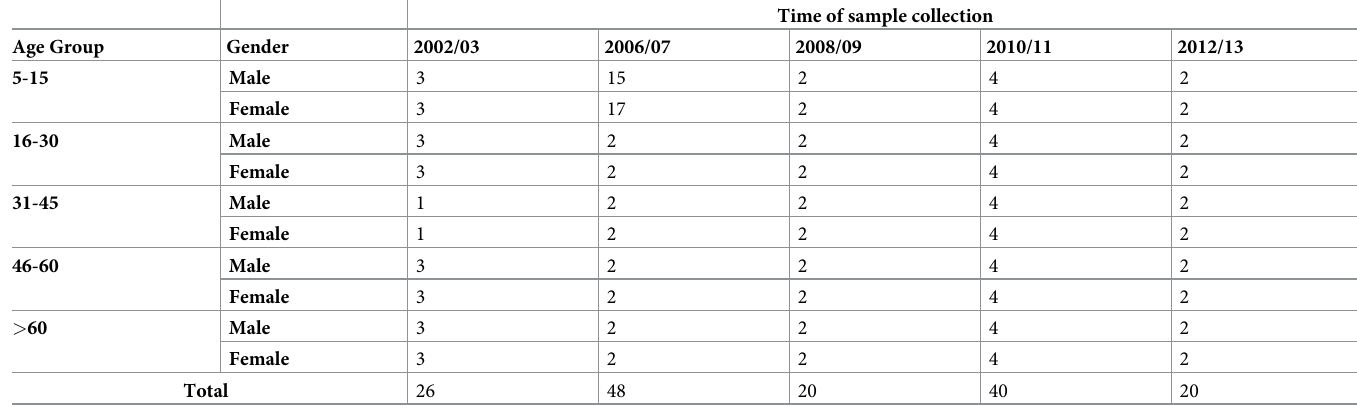
Table 1. Summary of the total number of pooled sample of OCPs, by each level of time of sample collection, gender and age